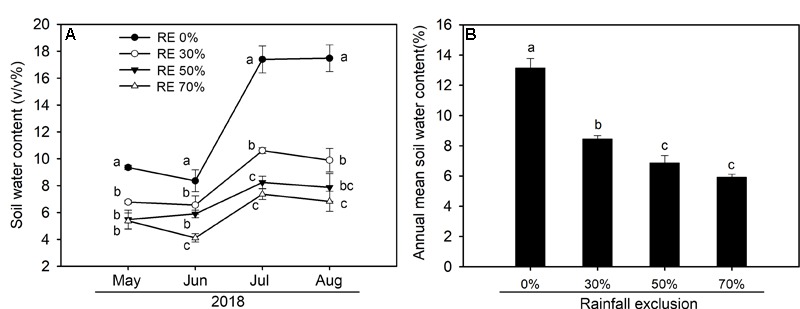
Seasonal dynamics of soil water content (V/V%) (A) and seasonal mean soil water content (B) at 0–10 cm depth of each rainfall exclusion treatment in 2018. RE0%, 0% rainfall exclusion; RE30%, 30% rainfall exclusion; RE50%, 50% rainfall exclusion; RE70%, 70% rainfall exclusion. Different lowercase letters indicate significant differences (P < 0.05) among the rainfall exclusion treatments. Data are reported as mean ± 1 SE (n = 4).